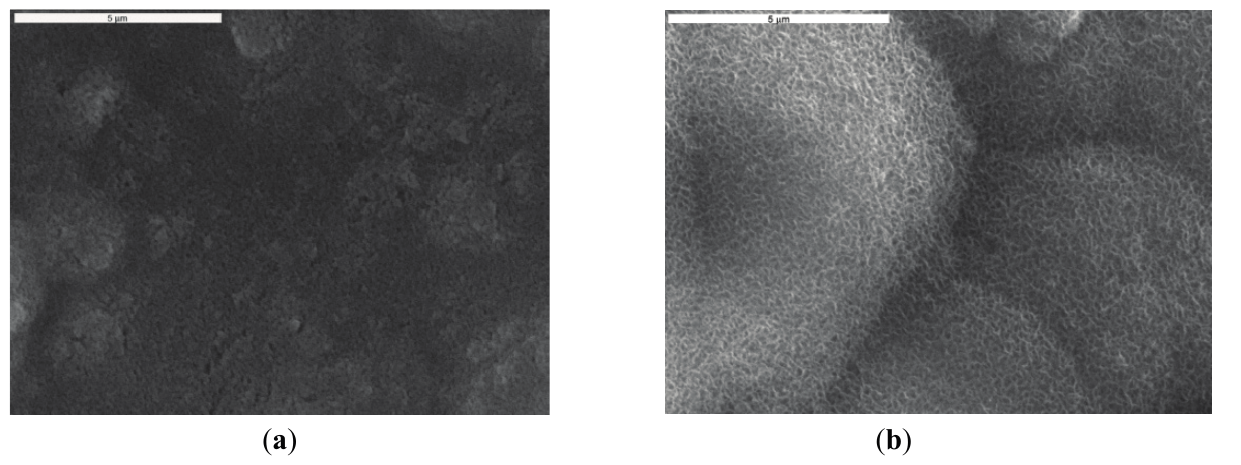
Figure 3. SEM micrographs of sintered Ag/HAP/Lig coating ( a ) before and ( b ) after immersion in SBF solution at 37 °C. Scale bar: 5 µm. Reprinted from [39] with permission. Copyright American Chemical Society